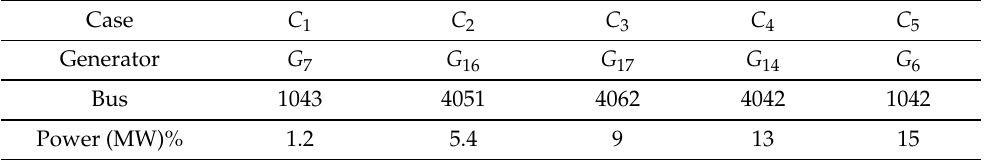
Table 1. Generator Replacement for Each